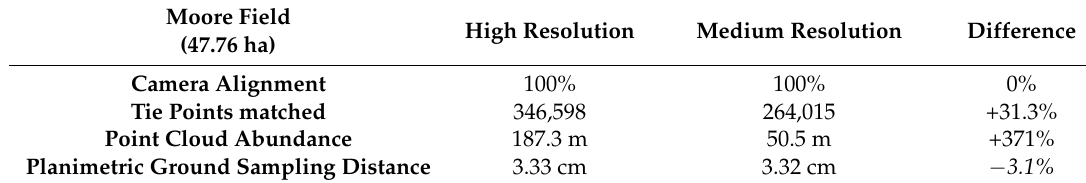
Table 3. Processing comparison for Agisoft PhotoScan high-resolution and medium-resolution workflows. Increased output performance (bold), decreased performance (italic), and no effect are given for the two